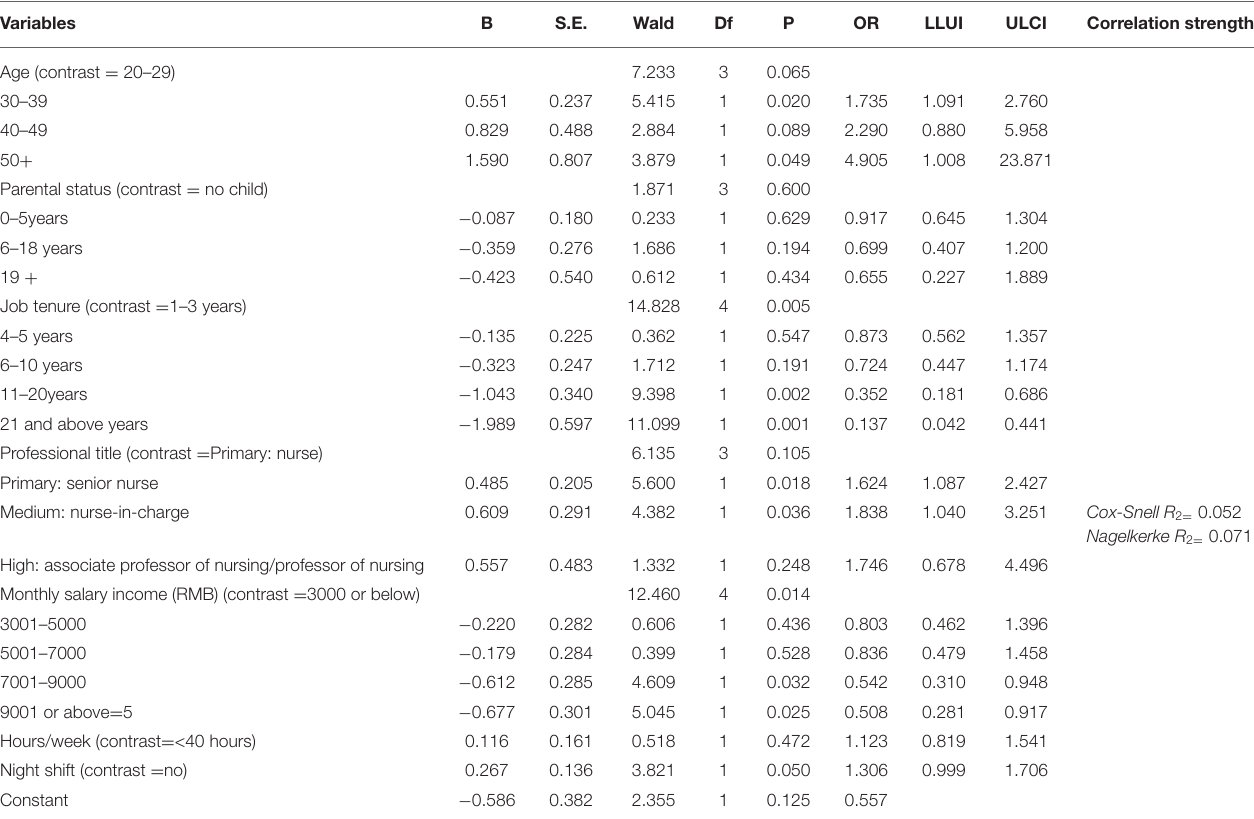
TABLE 6 | Multivariate logistic regression analysis of respondents (n = 1,133). Variables Correlation